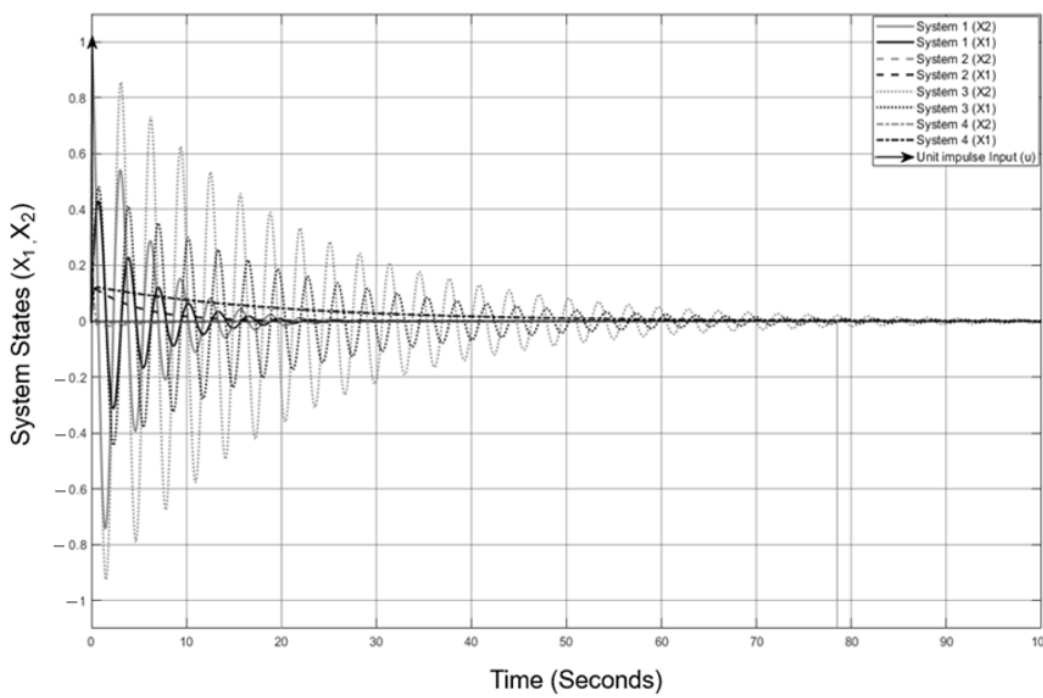
Figure 10. System equal dominant eigenvalues rendering equal settling times for a unit impulse in the form of a temporary input disturbance (Case example 1).